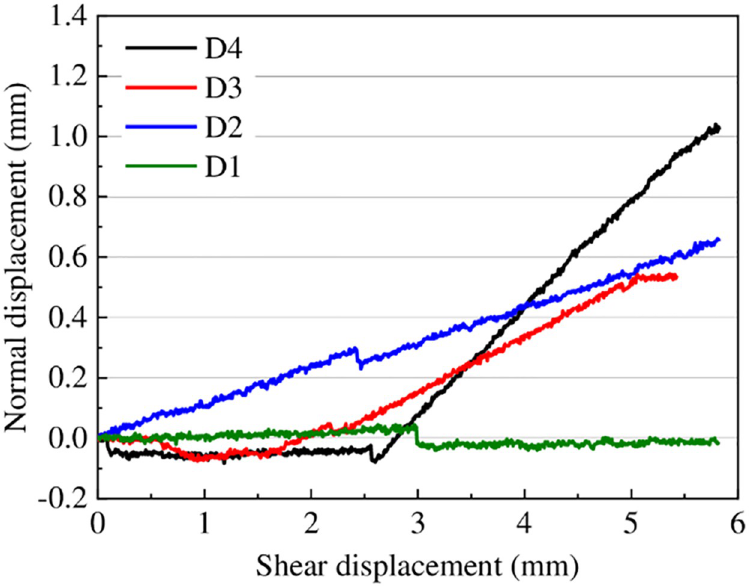
Fig 11. Normal displacement versus shear displacement of four joints under normal stress of 2 MPa.